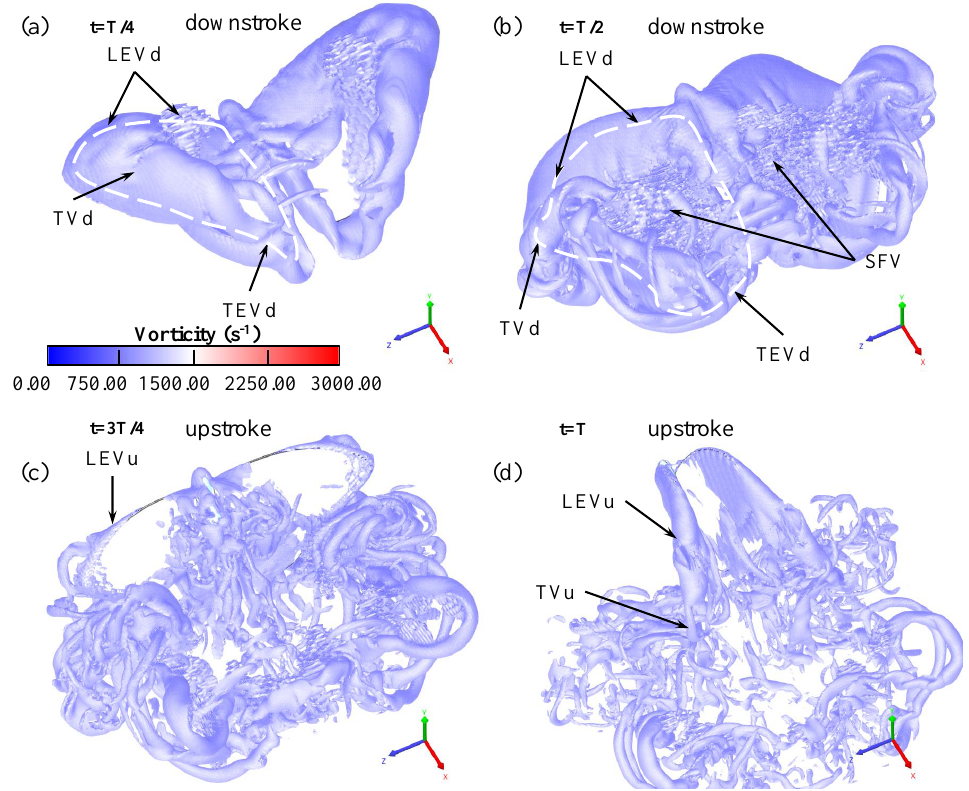
Figure 14. High-resolution visualization of 3D vortex structures in forward flight. The iso-surface of the vorticity ( ω = 7 × 10 2 s − 1 ) at ˆ t = 0.25 ( a ), 0.5 ( b ), 0.75 ( c ), and 1 ( d ),